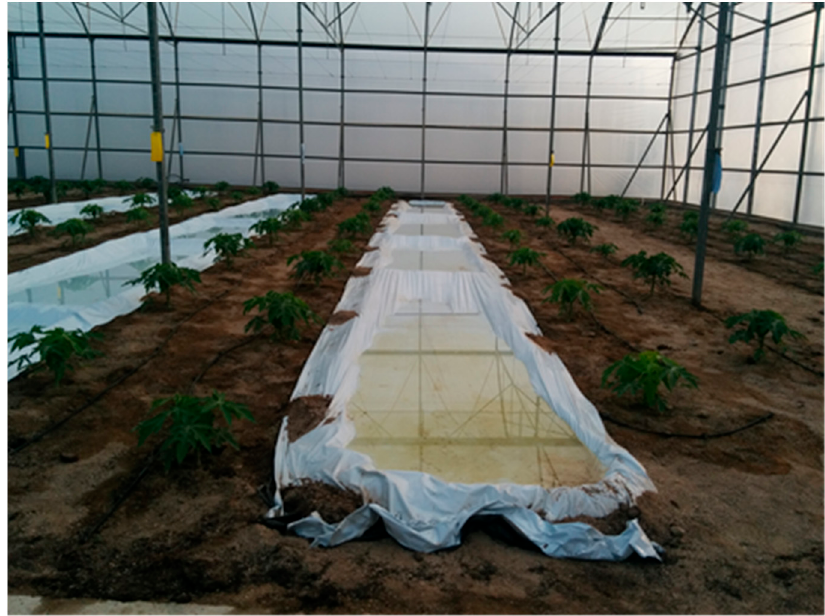
Figure 2. Plastic mulching of part of the floor surface for the incorporation of humidity in the